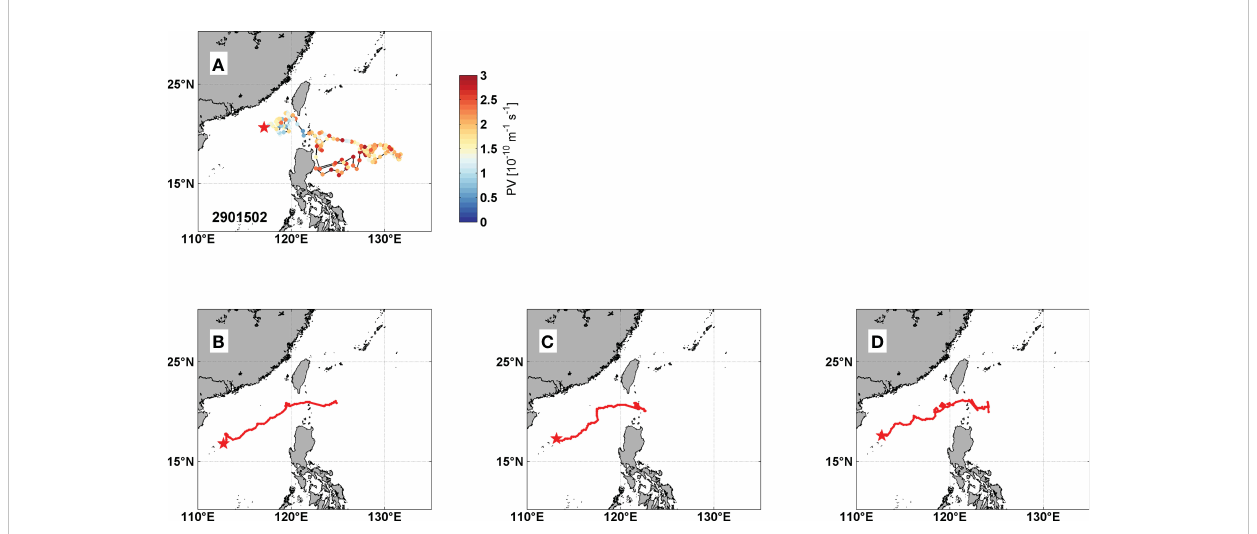
FIGURE 4 Trajectory of (A) Argo fl oat number 2901502 from 20 Sept. 2011 to 16 Apr. 2016 (In color, the PV of the STMW core layer). And trajectories of OFES low PV signals after moving across the Luzon Strait in the (B) 2008 case from 3 Aug. 2008 to 116 Dec. 2008, (C) 2015 case from 6 Jan. 2016 to 10 Jun. 2016 and (D) 2016 case from 23 Apr. 2016 to 12 Jan. 2017. The red stars indicate the terminal points of the